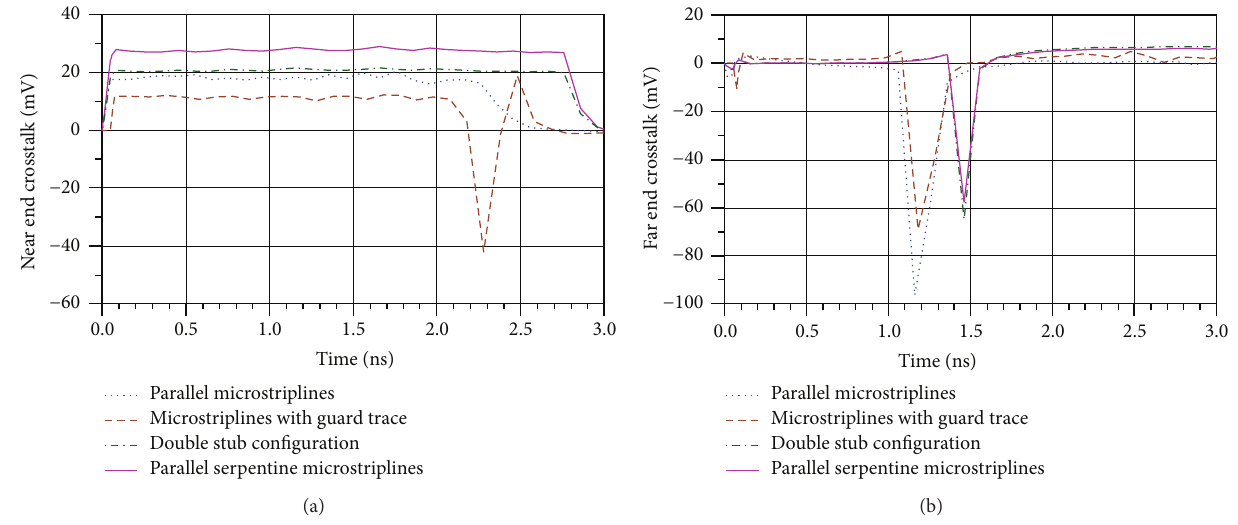
Figure 11: Time-domain measured results for various microstripline structures for the (a) near end crosstalk voltage and (b) far end crosstalk voltage.